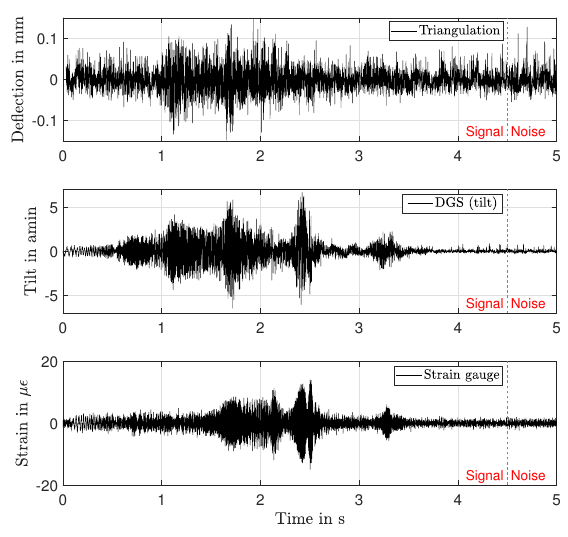
Figure 8. Sensor responses at one location at R = 170 mm and Ω = 60 Hz.